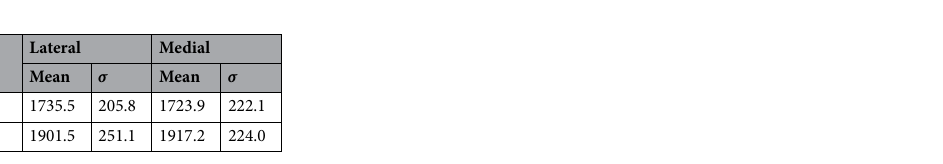
Figure 2. Distributions of pixel brightness values for Lateral (left) and Medial (right) images, Control (Blue) and Case (Red).